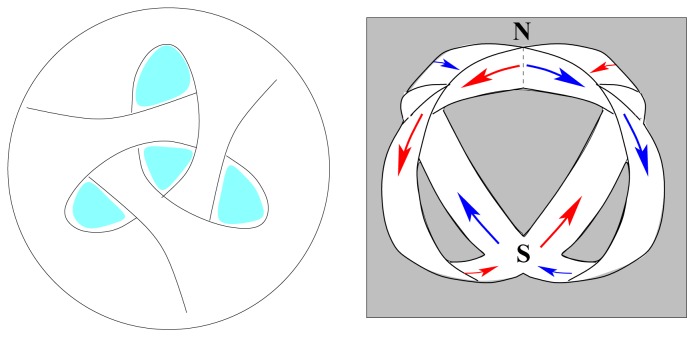
(a) Drawing of Boy’s surface [43]; (b) Intersecting Möbius bands.